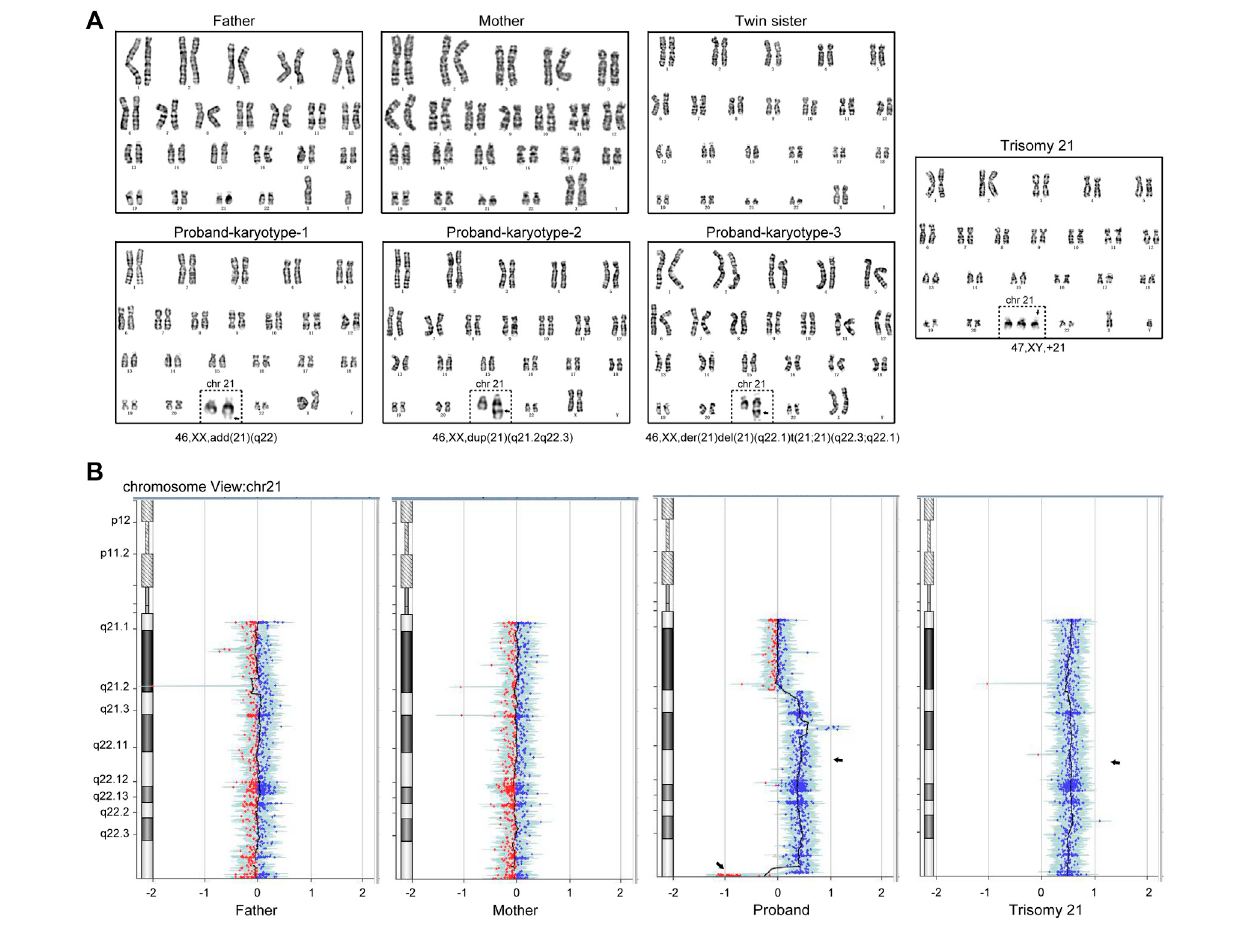
FIGURE 1 | A couple gave birth to a Chimeric child with a partial trisomy 21 after IVF and EF. (A) Giemsa staining and analysis of the cultured peripheral blood mononuclear cells in the family members, in which the proband exhibits the combination of three karyotypes: 46,XX, add (21) (q22), 46,XX, dup (21) (q21.2q22.3)